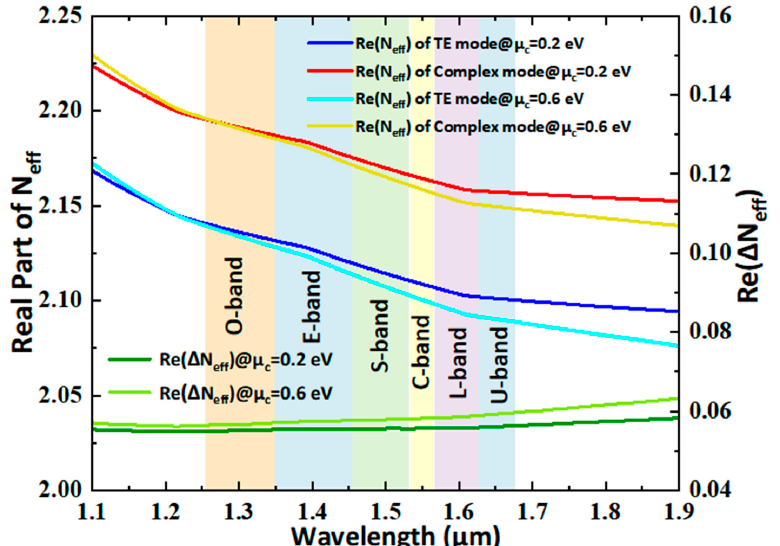
Figure 18. Re( N eff ) and Re( ∆ N eff ) of the TE mode and the complex mode vary with wavelength.